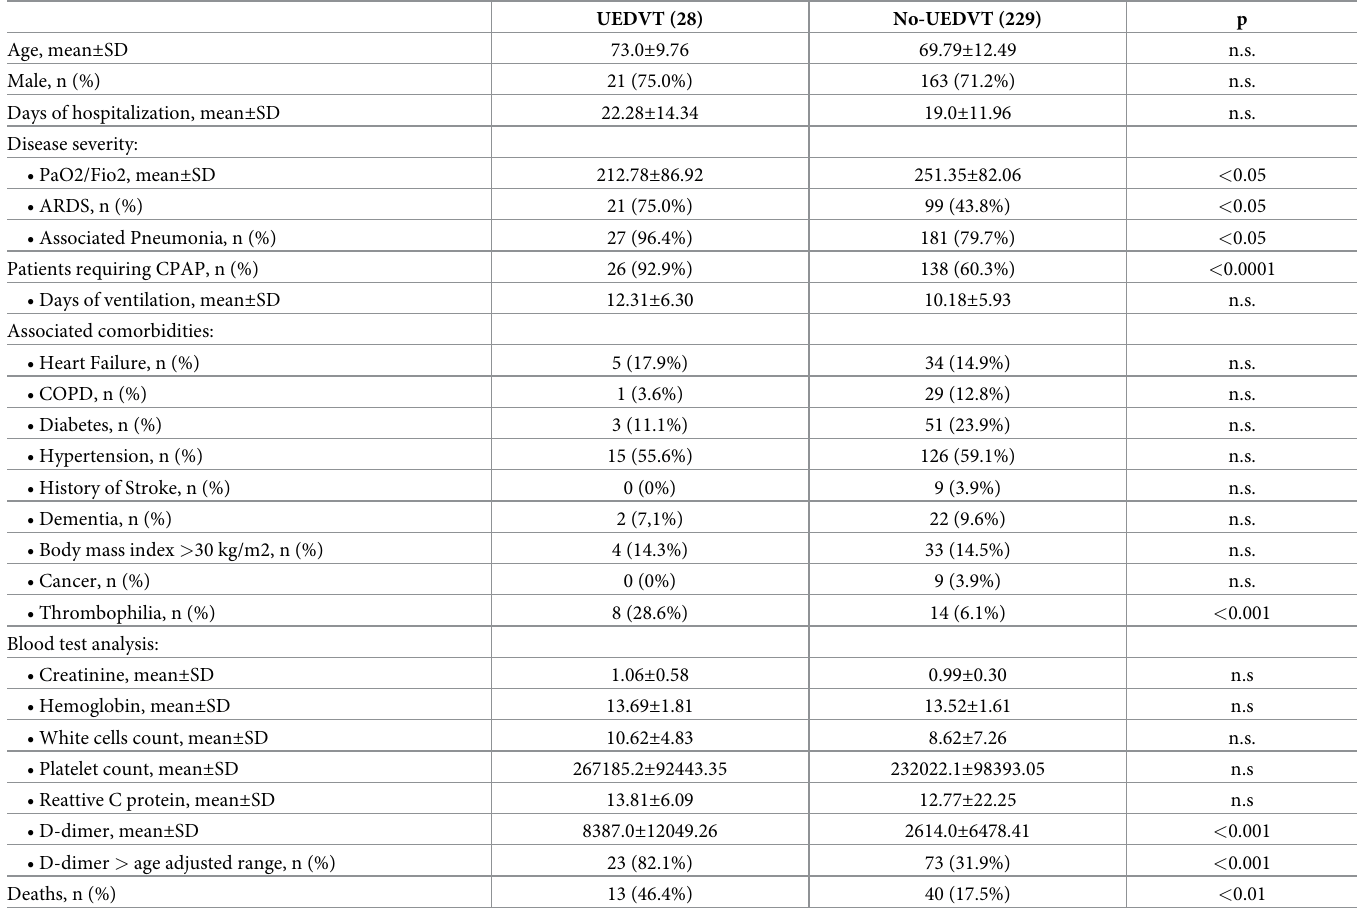
Table 3. Comparison between patients with UEDVT and patients without.